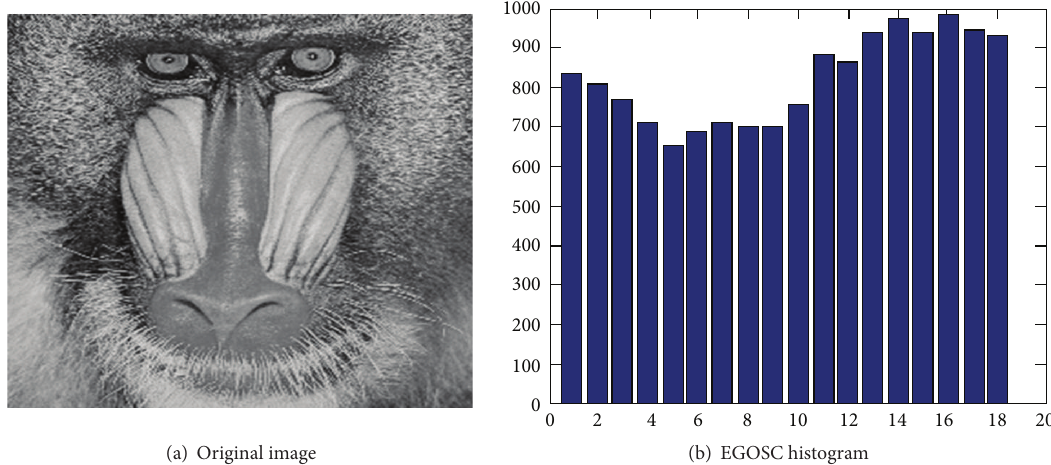
Figure 2: Image of baboon and its EGOSC histogram.